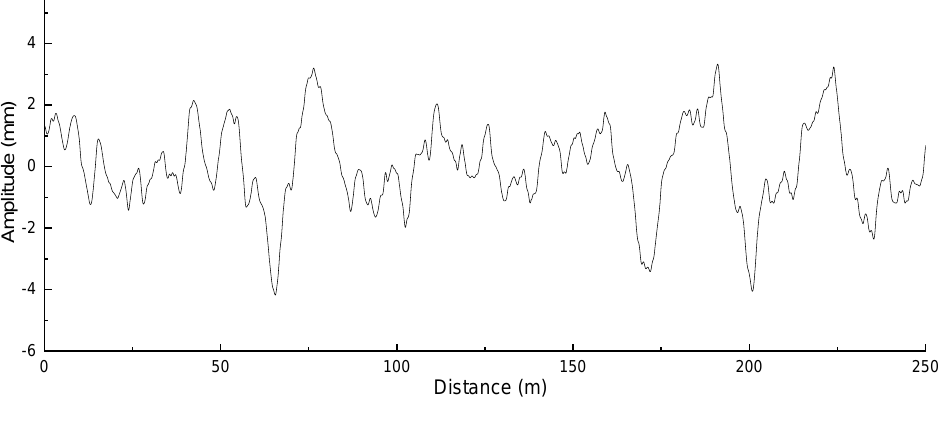
Figure 5. Track irregularity with distance.